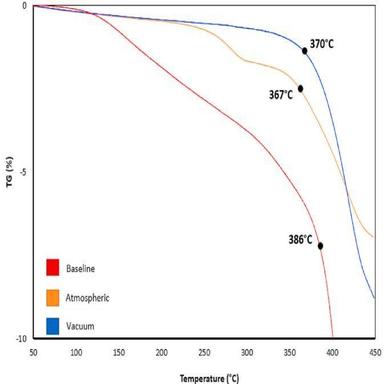
TGA data of atmospheric and vacuum silicone rubber.